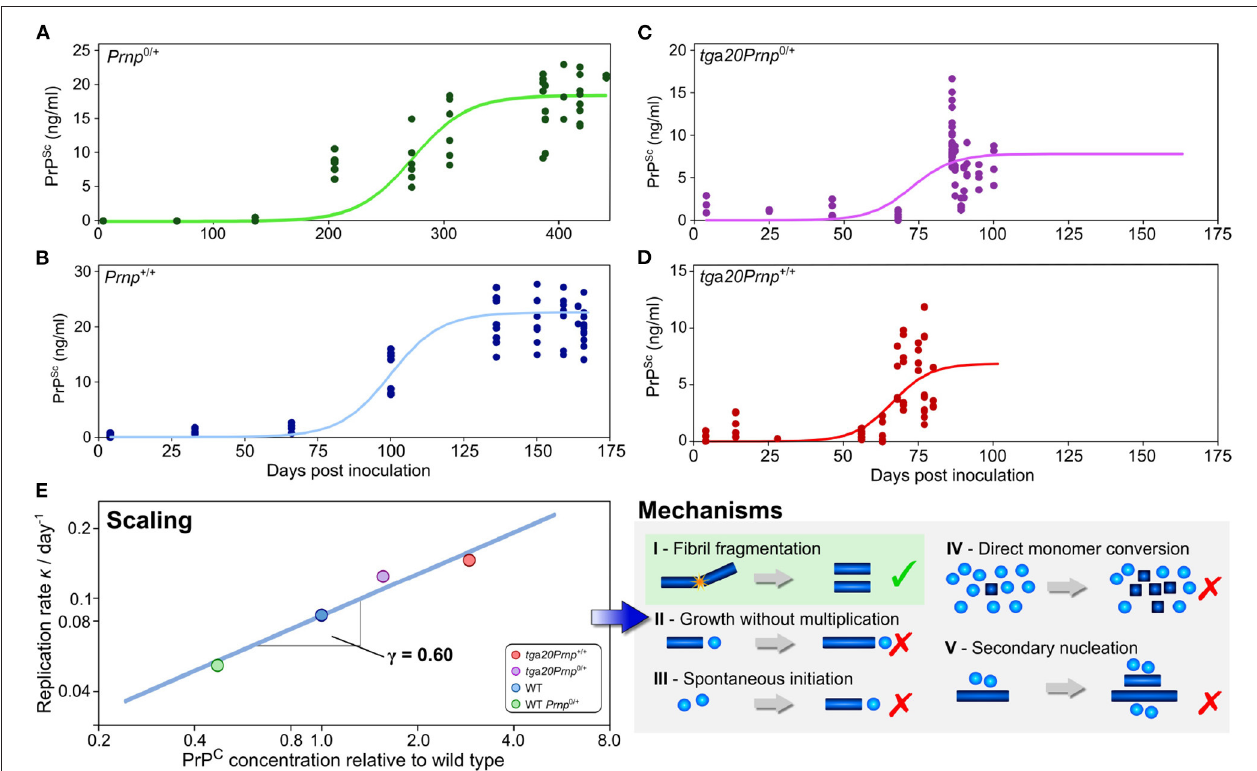
FIGURE 5 | Use of scaling analysis to determine the mechanism of replication in a living system. The concentration of prions was determined as a function of time after inoculation by prions in a number of different mouse lines, with technical and biological replicates shown as solid points (A–D) . The mouse lines express the different amounts of the monomeric precursor, PrP, as shown in (E) relative to the wild type line Prnp + / + . The rate of replication is extracted from those data by fitting of a minimal model (solid lines). In turn, the variation of the replication rate with the concentration of the precursor protein PrP allows one to determine the scaling exponent, γ = 0.6 (E) . This low scaling, with the rate increasing approximately with the square root of the protein concentration, allows a range of mechanisms to be excluded and is consistent with the mechanism of prion multiplication determined for the purified protein in vitro . Adapted from Meisl et al.